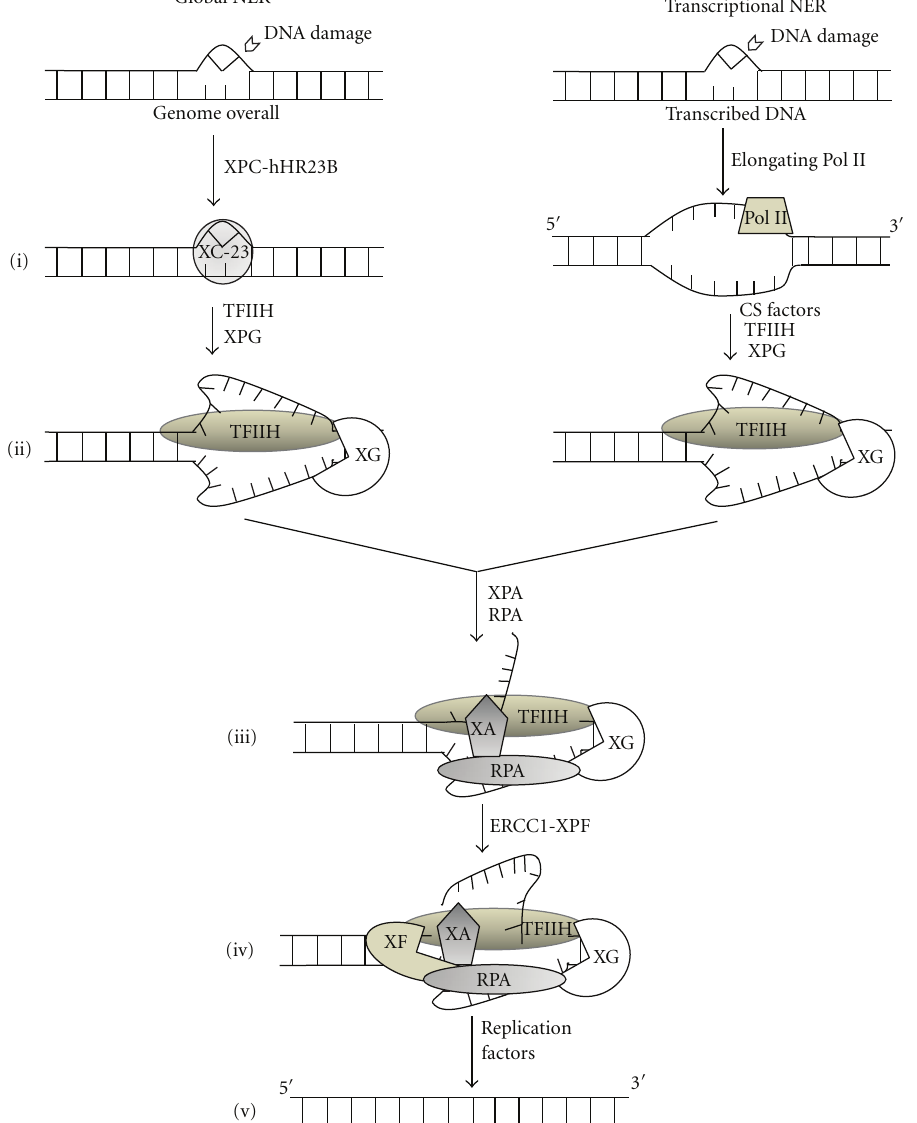
Figure 2: Molecular model of the NER system. Quoted from [7] and modified. (i) XPC-hHR23B (XC-23) binds and senses DNA distorting NER lesions in global NER, resulting in conformational alterations of the DNA. In transcriptional-coupled repair (NER), lesions are detected by elongating RNA polymerase II (Pol II). (ii) (left) XPC-hHR23B attracts TFIIH together with XPG (XG). TFIIH creates a 10- to 20- nucleotide open DNA complex. XPC-hHR23B is released. (right) CSA, CSB, TFIIH, XG, and possibly cofactors displace the stalled Pol II and then bind to the lesions. (iii) XPA (XA) and RPA bind and stabilize the open DNA complex. (iv) XG that is positioned by TFIIH and RPA cuts the damaged nucleotides at the 3 (cid:2) site and ERCC-XPF (XF) that is positioned by RPA and XPA cuts them at the 5 (cid:2) site. (v) DNA polymerase fills the gap and ligase seals the nick. Normal nucleotide sequence is consequently restored. Contacts drawn between molecules reflect reported protein-protein